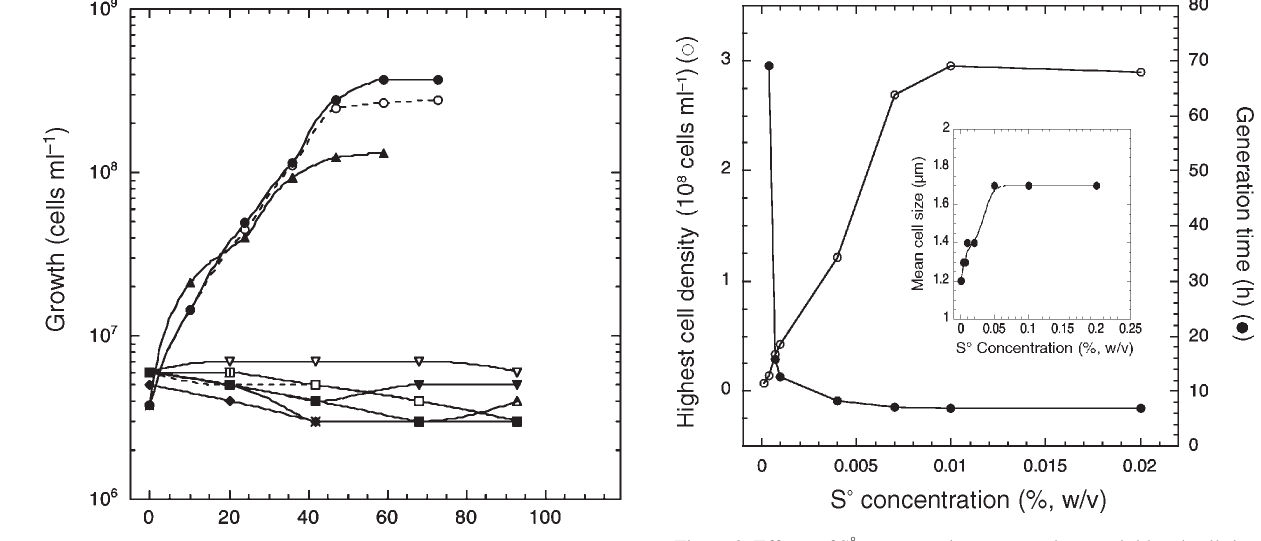
Figure2. Effectsof S ° concentrationon growth rate, yieldand cellsize of S. marinus . Open circles denote cell density at the end of growth, and closed circles denote generation time. The inset shows the mean cell size of S. marinus . Cells were grown in 25 ml of modified 0.8× SME medium at 85 °C. Cell size was determined by phase-con- trast microscopy. Mean cell size (means ± SD) was determined from 20 cells at late